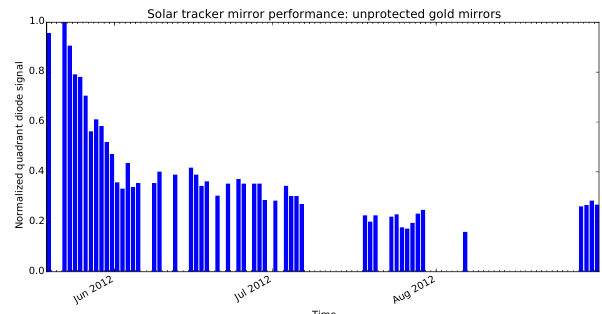
Figure 3. Reflectance loss of the original unprotected gold-coated mirrors (Bruker) on Ascension Island. The normalised maximum light intensity per day at the quadrant diode of the solar tracker is plotted as a measure of reflectance loss over time. The plot shows the combined reflectance loss for both solar tracker